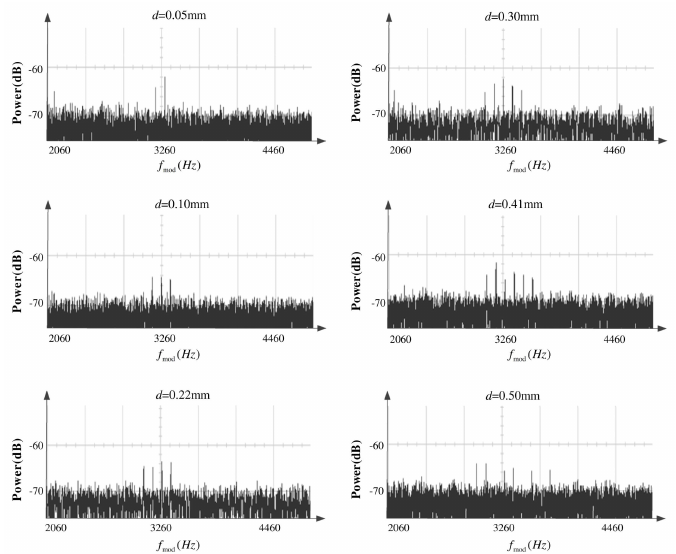
Figure 13. Experimental results when introducing different lateral misalignments. Adapted with permission from ref.